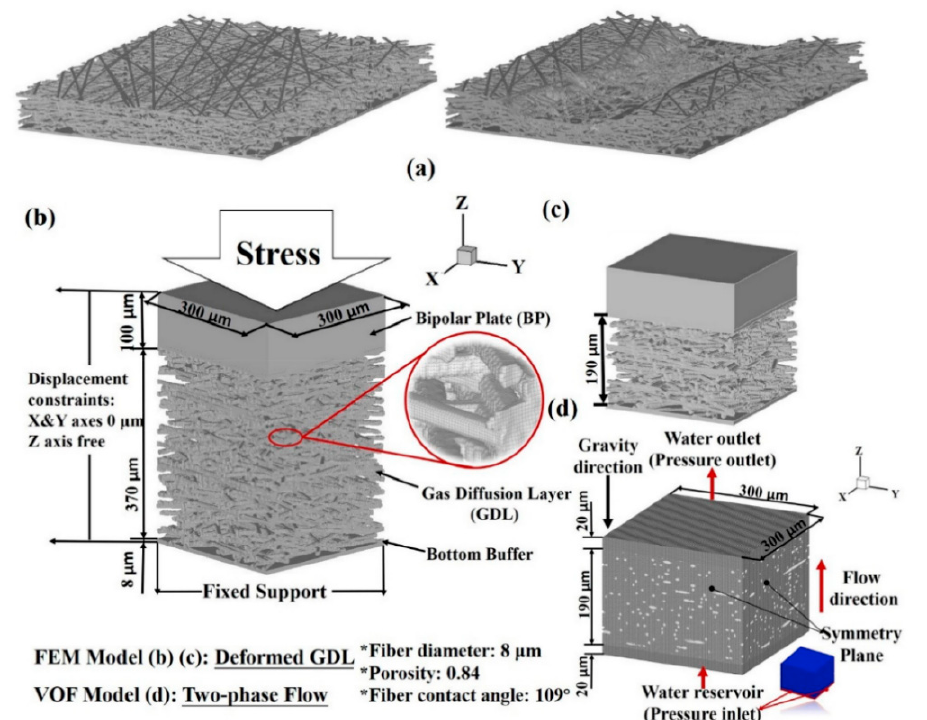
Figure 7. Schematic diagram of FEM model and VOF model based on GDL microstructure in a PEMFC: ( a ) morphology of uncompressed and compressed GDL; ( b ) computational domain and boundary conditions for FEM model; ( c ) computational domain of FEM model; ( d ) the computational domain and boundary conditions for the VOF model [35].